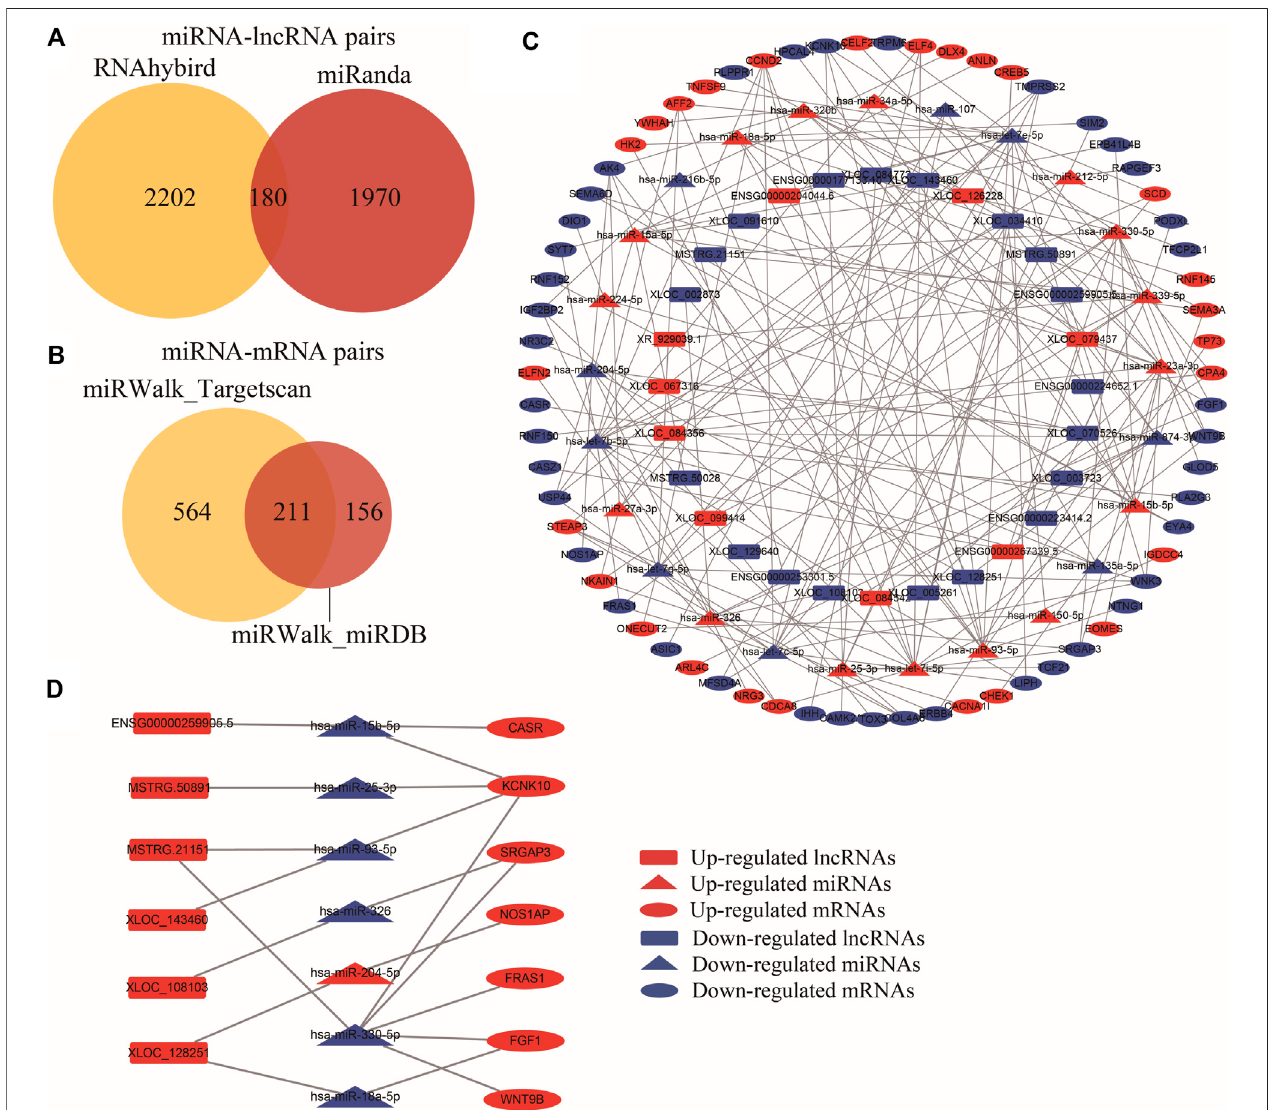
FIGURE 5 | Construction of immune-associated ceRNA network. (A) Venn diagram showed the overlapped miRNA-lncRNAs pairs predicted by miRanda and RNAhybrid. (B) VenndiagramshowedtheoverlappedmiRNA-mRNAspairspredictedbymiRWalk,Targetscan,andmiRDBdatabase. (C) TheceRNAnetworkconsists of 28 TIR-lncRNAs, 25 TR-miRNAs, and 66 mRNAs. LncRNAs, miRNAs, and mRNAs are respectively represented by rectangles, triangles, and ellipses. The red color represented upregulated genes, and the blue color represented downregulated genes in the tumor tissues relative to control tissues. (D) The candidate relevant RNAs were further screened based on the correlation between lncRNAs and